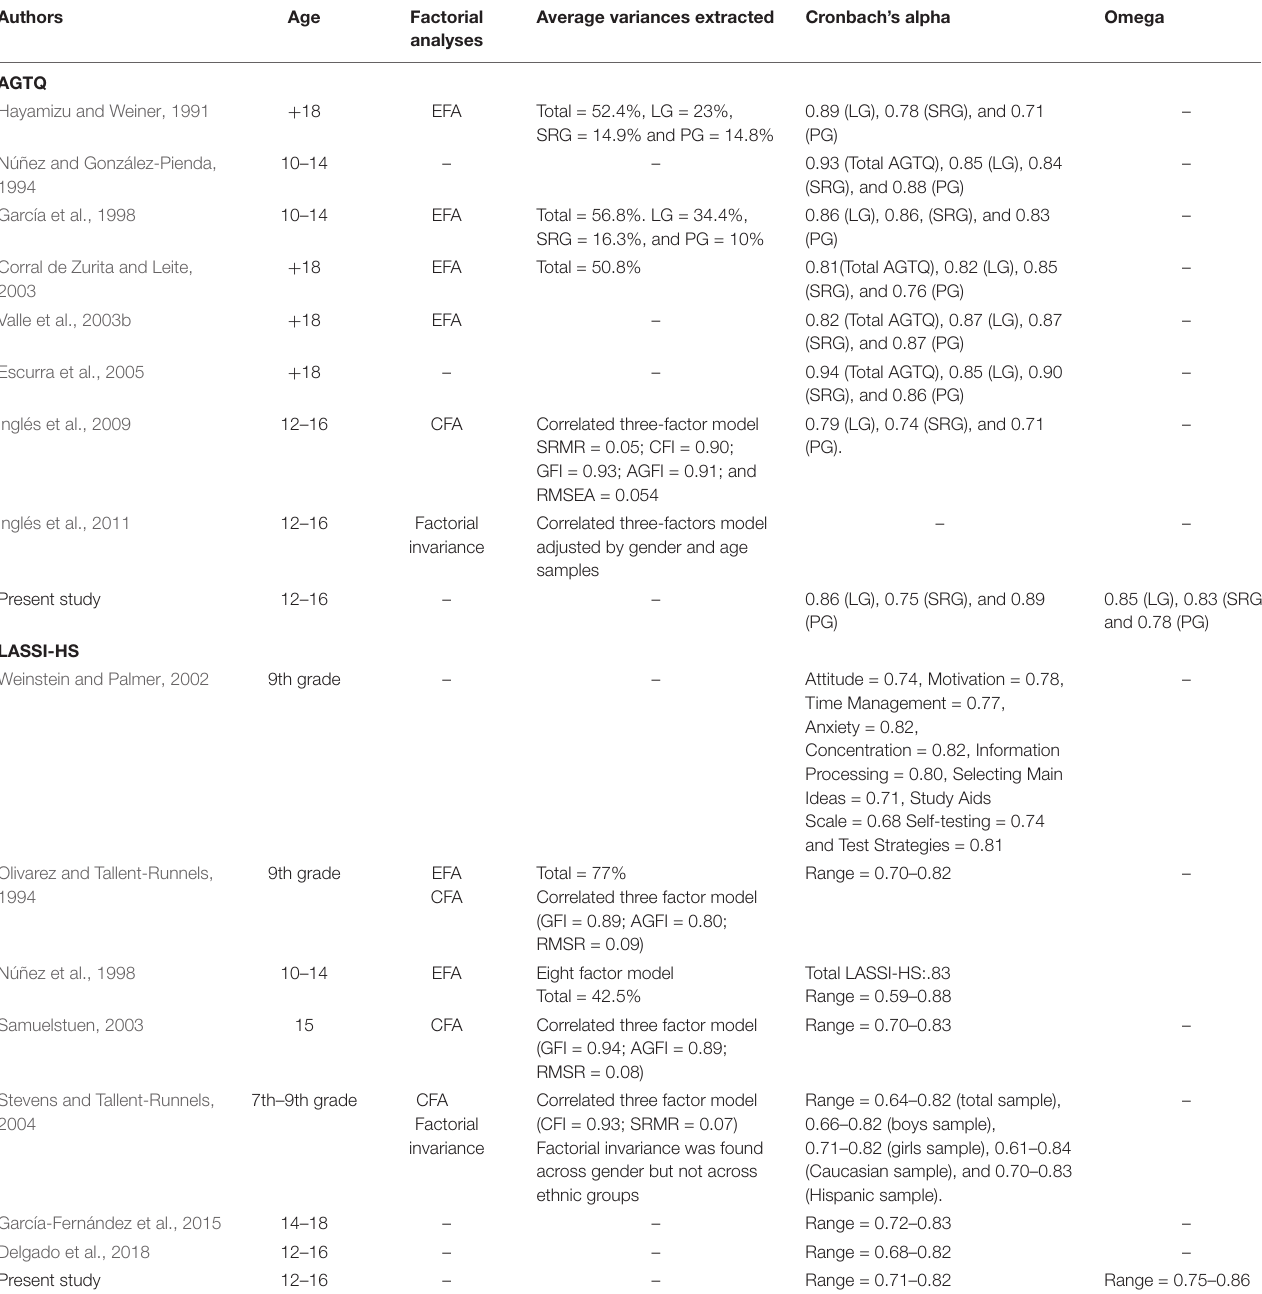
TABLE 2 | Factorial analyses, average variances extracted, Cronbach’s alpha and omega values for previous studies and the present studies using the Achievement Goal Tendencies Questionnaire and the Learning and Studies Skills Inventory-High School